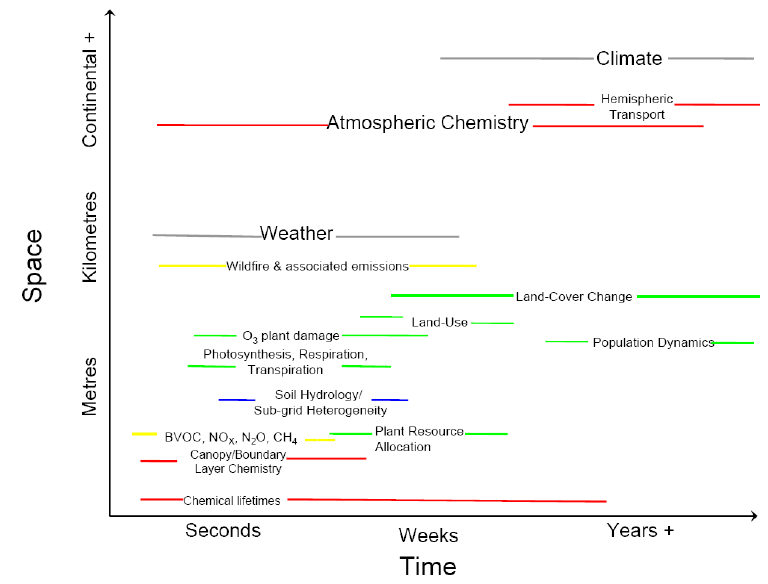
Fig. 3. Characteristic spatial and temporal scales associated with DGVMs and climate models, trace-gas biosphere-atmosphere exchange and atmospheric chemistry. Green lines: processes associated with plant physiology/land cover; yellow lines: trace gas emissions; blue: surface hydrology/energy balance; red: chemical transformations and related processes; grey: weather and climate. (McGuire et al., 2001; Friend et al., 2007; Hickler et al.,